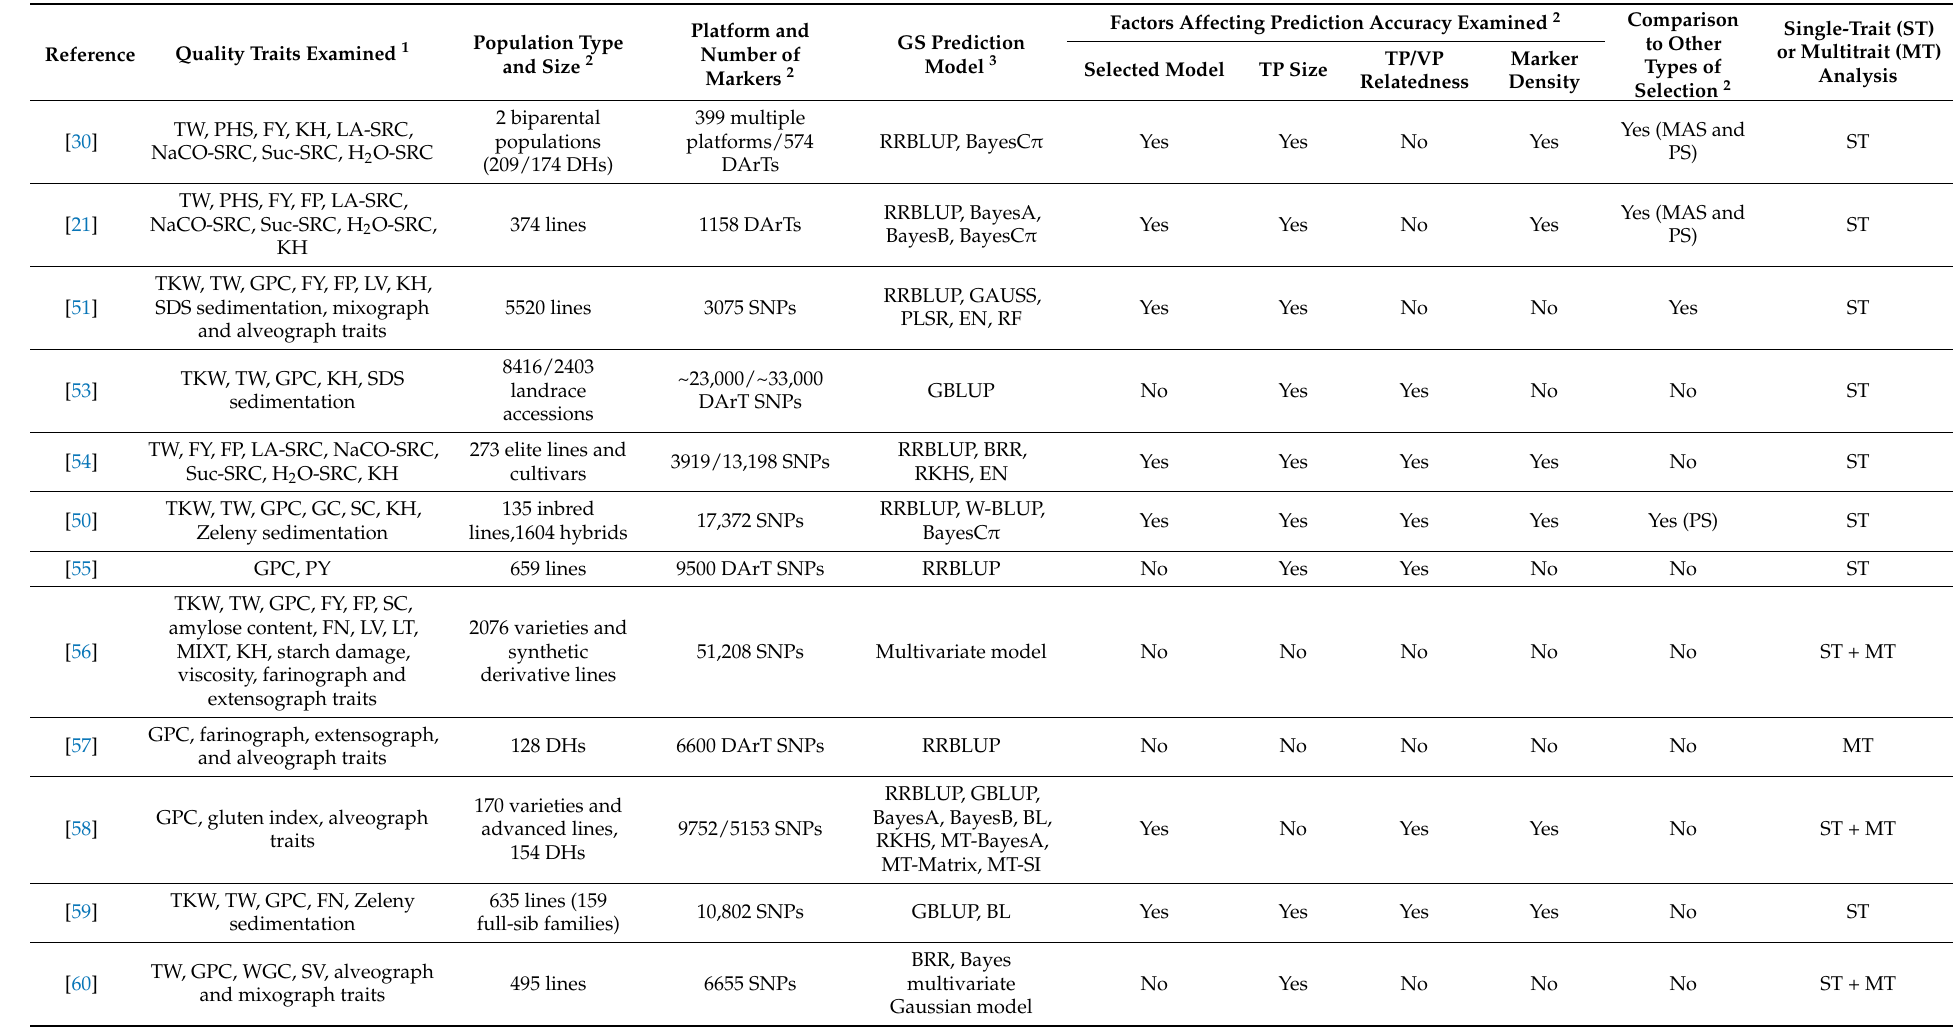
Table 1. Overview of references for genomic selection studies covering wheat quality